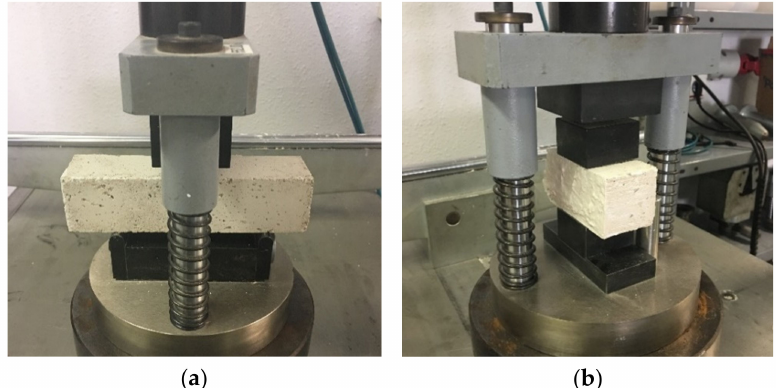
Figure 5. Samples during the mechanical tests. ( a ) Flexural strength; ( b ) compressive strength.